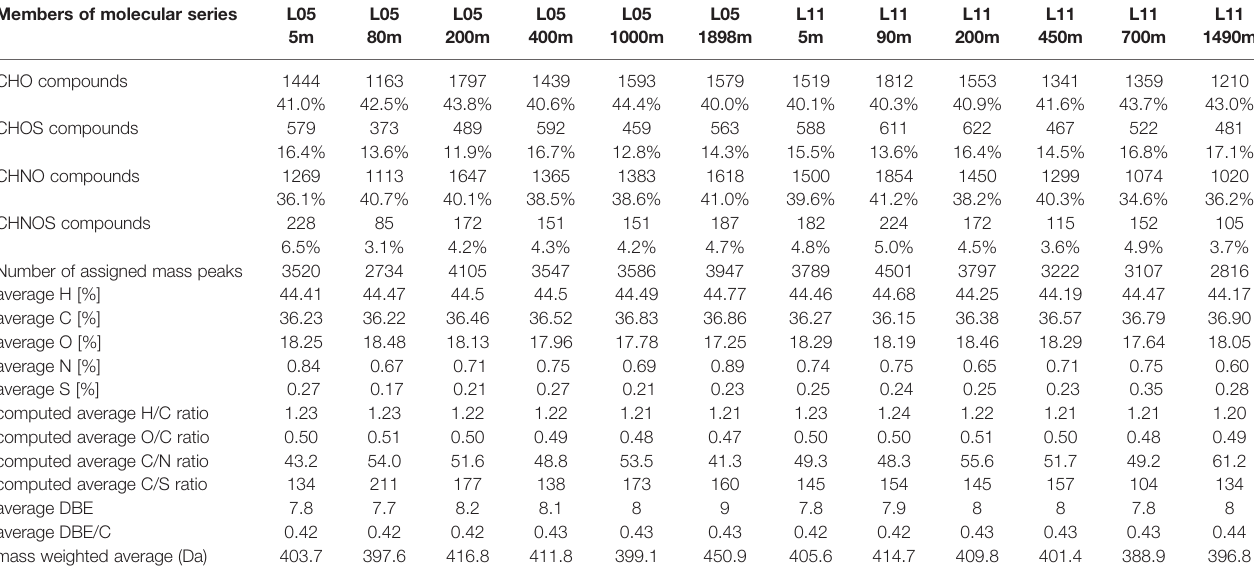
TABLE 1 | Counts of mass peaks and FTICR/MS-derived bulk parameters as computed from negative electrospray (ESI) 12 T FTICR mass spectra for singly charged ions. Members of molecular